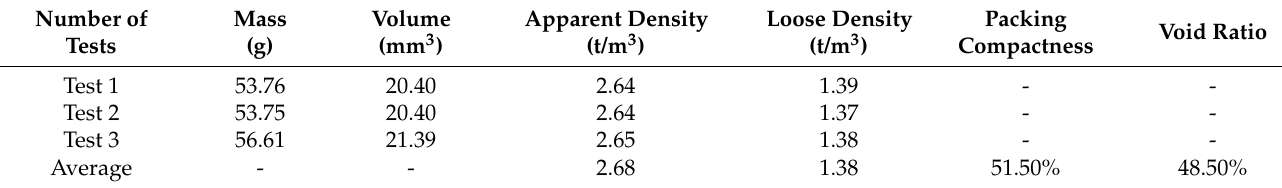
Table 2. Physical properties of tailings.